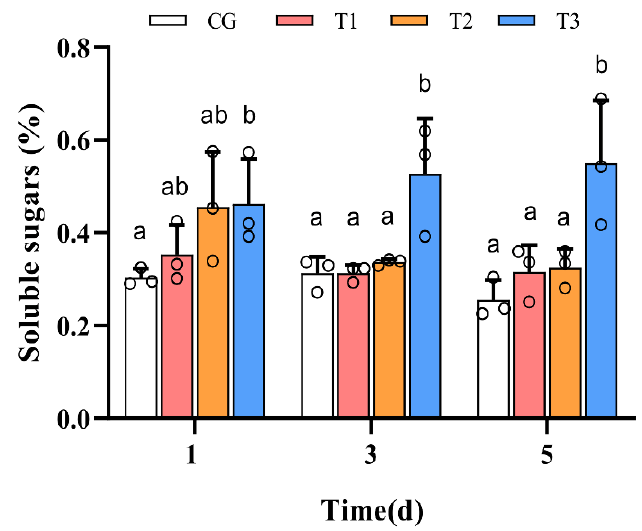
Figure 4. The content of soluble sugars for M. spicatum in each treatment on day 1, 3, and 5 (data points). CG: control group; T1: 0.1 times of original decomposing liquid; T2: 0.2 times of original decomposing liquid; T3: 0.4 times of original decomposing liquid. Error bars represent standard deviation (n = 3). Different letters on top of column indicate significant differences among treatments at the 0.05 significance level (Tukey HSD). Each dot represents a replicate.